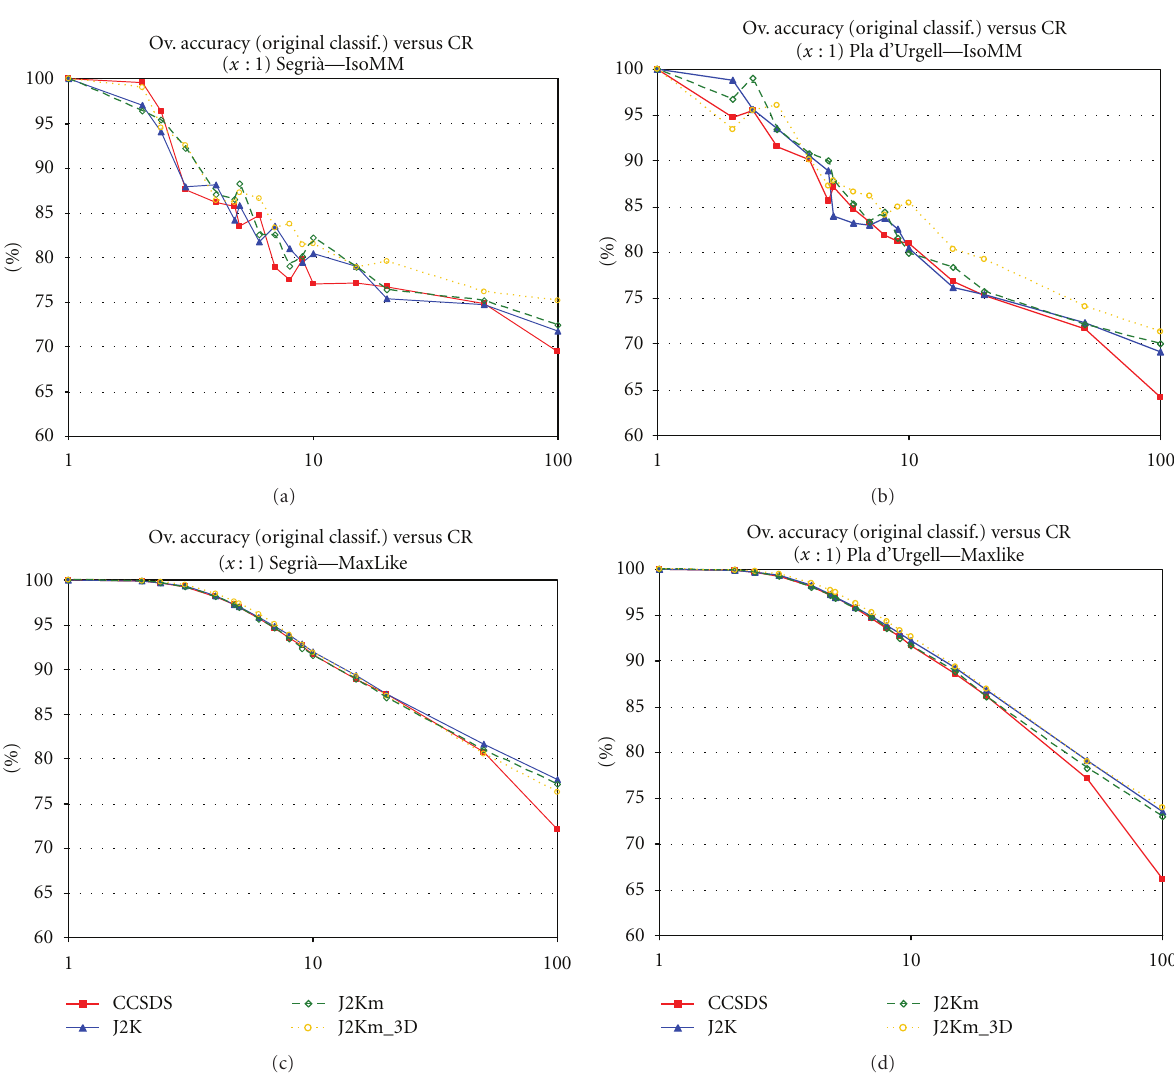
Figure 9: Overall accuracy (in %) computed using classification of noncompressed images as ground-truth in relation to the compression ratio (CR, expressed as x :1, e.g., 5:1). The two study areas, two classifying methods and four compression scenarios are